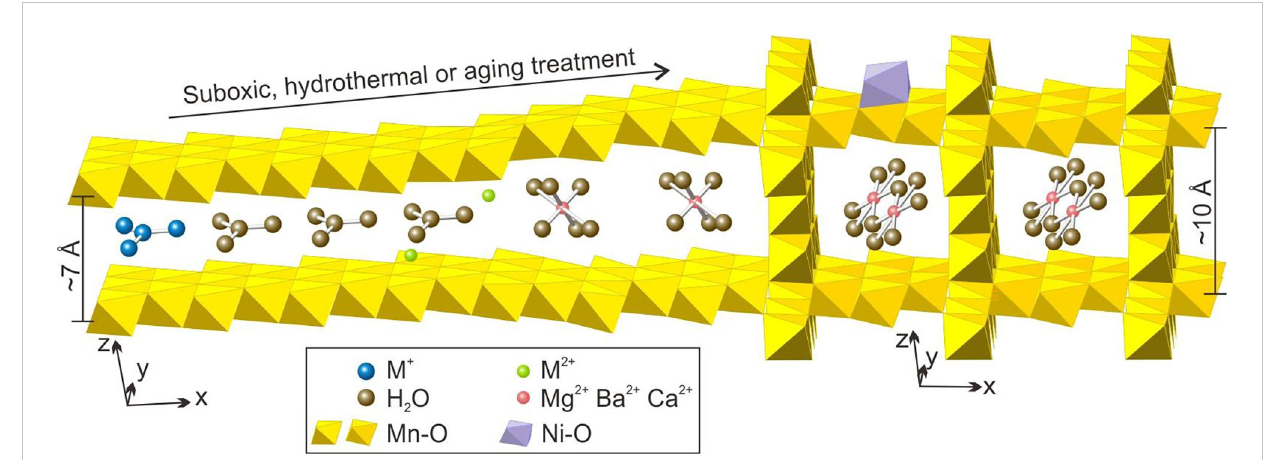
FIGURE 11 Schematic model of the Mn-oxides transformation in the SCS polymetallic crusts and